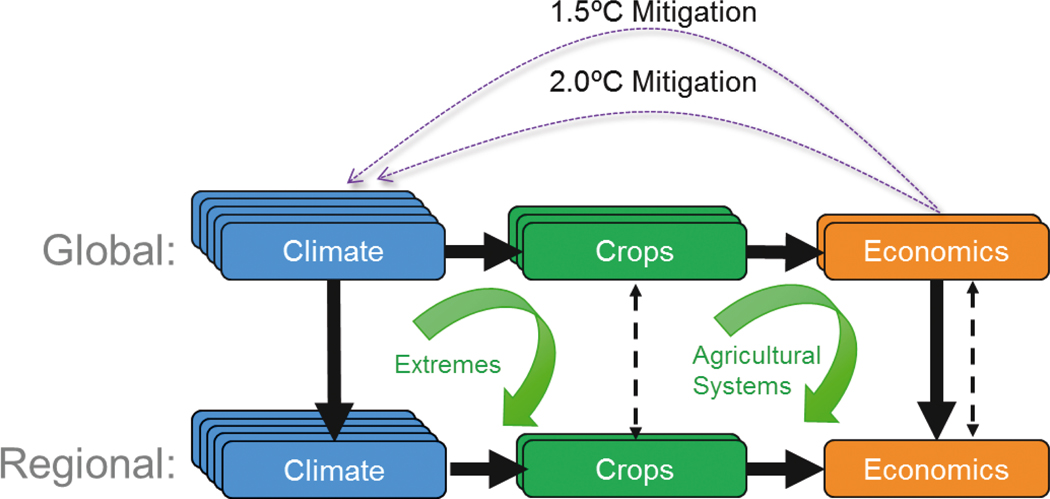
Coordinated Global and Regional Assessments (CGRA) linking global and regional scales, disciplines, and multiple models with a focus on +1.5° and +2.0°C warming worlds. Extreme events and alternative agricultural systems for adaptation and mitigation are also explored on the nexus of disciplines and scales. Solid lines indicate direct use of model outputs as inputs for successive modeling in the core CGRA application, while dashed lines indicate cross-scale comparisons enabled. Mitigation scenarios examine potential policy and socioeconomic development pathways that would limit cumulative greenhouse gas emissions and determine resulting climate stabilizations. The CGRA also enables multi-perspective analysis of the agricultural sector impacts of extreme events and the resilience of alternate future agricultural systems